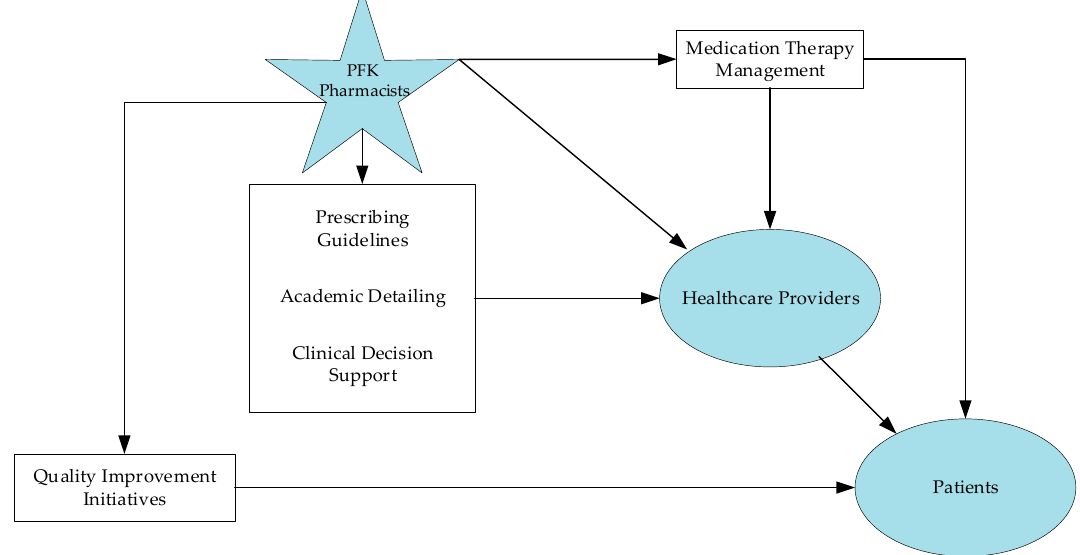
Figure 1. Diagram of population health management strategies employed by pharmacists working within a pediatric accountable care organizations (ACO) to help deliver high-value health care to its patients.